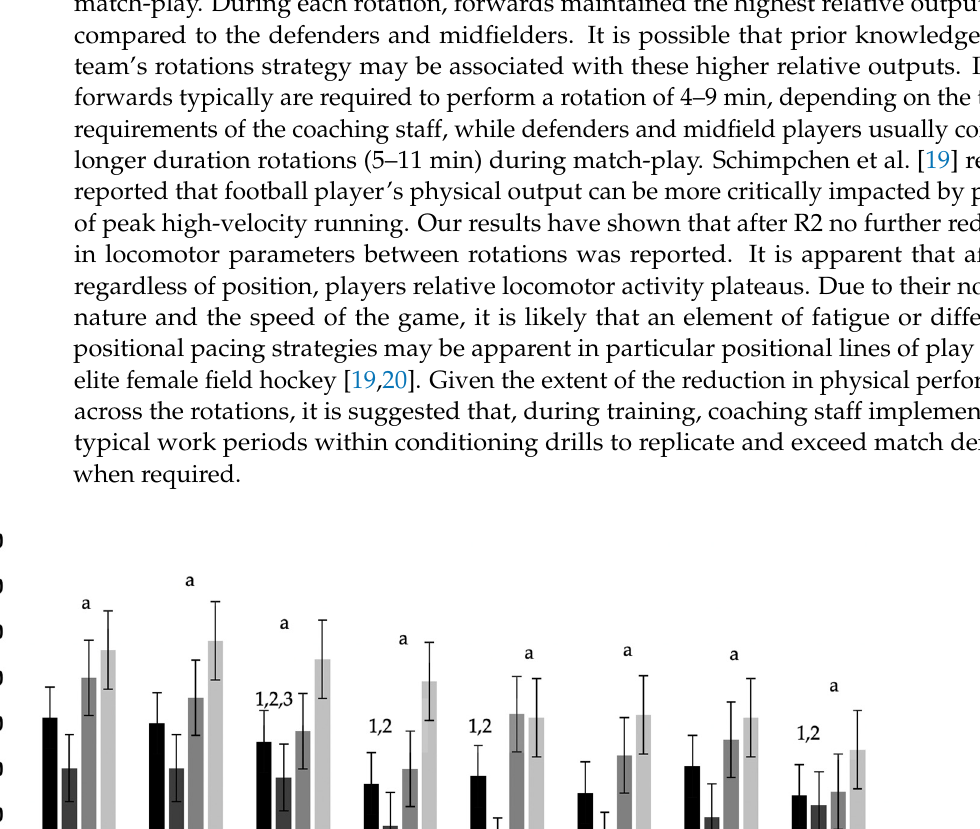
Figure 2. The average relative high-speed distance m·min − 1 of elite female field hockey players across each rotational pe- riod during competitive match-play. The letters a, b, c signify the positional variation between the defenders (a), midfield (b) and forwards, while 1,2,3,4,5,6,7,8 represent the significant difference across each rotation when compared to each other. Irrespective of positions. elite female field hockey players complete on average eight rotations during competitive match-play. During these individual rotations, players are likely to spend a mean time of 7 ± 1 min on their feet. Within these 7 min, players are likely to cover an average relative total distance of 124.9 ± 10.7 m·min − 1 with a relative high-speed distance of 20.7 ± 5.8 m·min − 1 . When each rotation was considered, a significant main effect was observed for relative total distance (p ≤ 0.001; ր 2 = 0.04; medium), relative high-speed distance (p ≤ 0.001; ր 2 = 0.03; medium), and the number of sprints (p ≤ 0.04; ր 2 = 0.01; small). A significant decrease was reported for relative total distance for R1 and R2 when com- pared to other rotations completed by players during match-play (Figure 1). Similar to